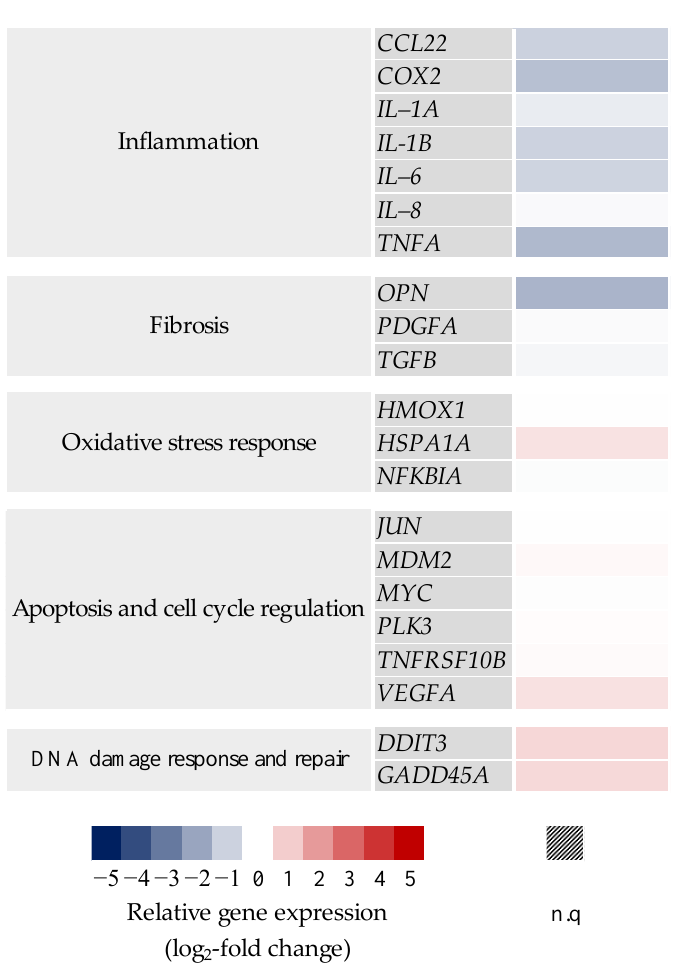
Figure 5. Gene expression profiles of BEAS-2B/dTHP-1/CCD-33Lu triple-cultures after exposure to mechanically treated CF (mCF) . Triple-cultures were exposed to CF samples with average surface doses of 7.00 ± 1.25 µg/cm 2 mCF for 1 h and post-incubated for 23 h. Gene expression changes in cells from the apical compartment (BEAS-2B and dTHP-1) are shown. The results are depicted as the log 2 -fold change in the relative gene expression. A red color represents the induction; a blue color, the repression of a gene. The mean values of at least three independent experiments are dis- played. n.q.: not quantifiable due to low expression levels.